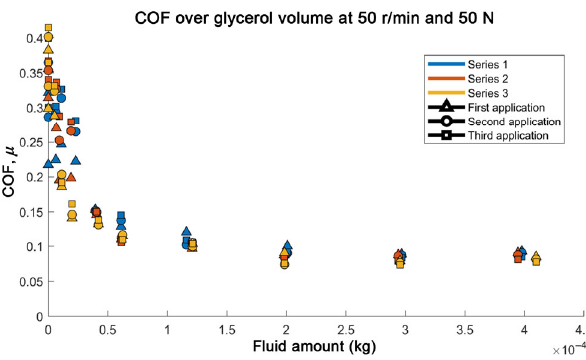
Fig. 12 COF vs. amount of fluid for the system with the coarsely filed pin.